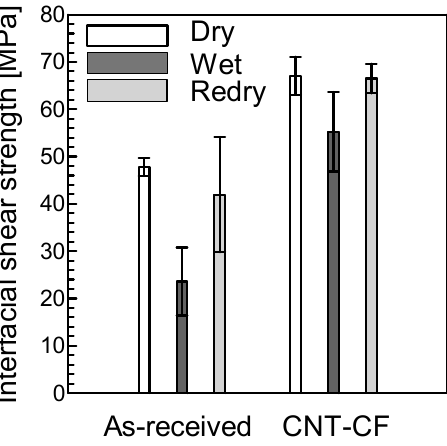
Figure 7. Interfacial shear strength. (N = 5, mean ± S. D.)